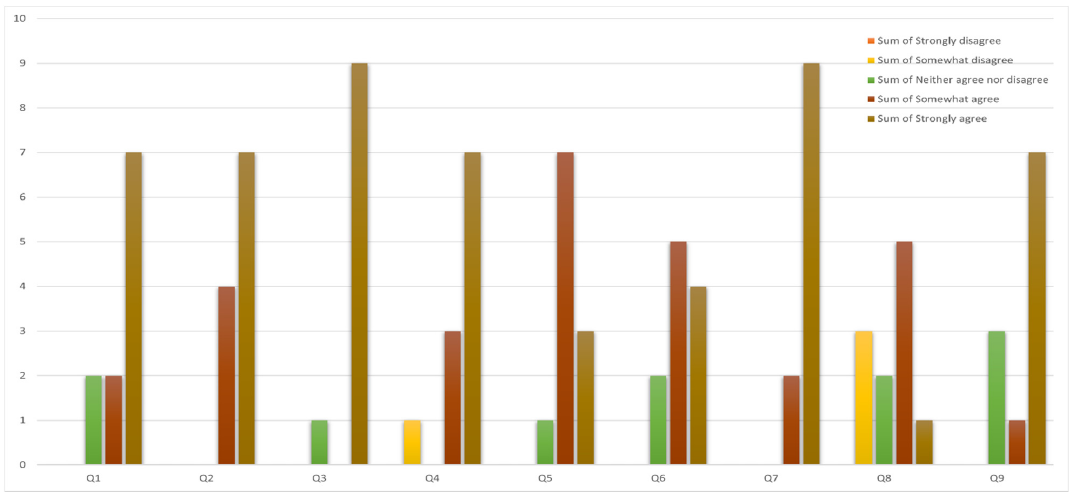
Figure 4. This bar chart shows participants (n = 11) response to questionnaire items (see Table 3) scored on 5-scale Likert (strongly disagree = 1, somewhat disagree = 2, neither agree nor disagree = 3, somewhat agree = 4, and strongly agree = 5).